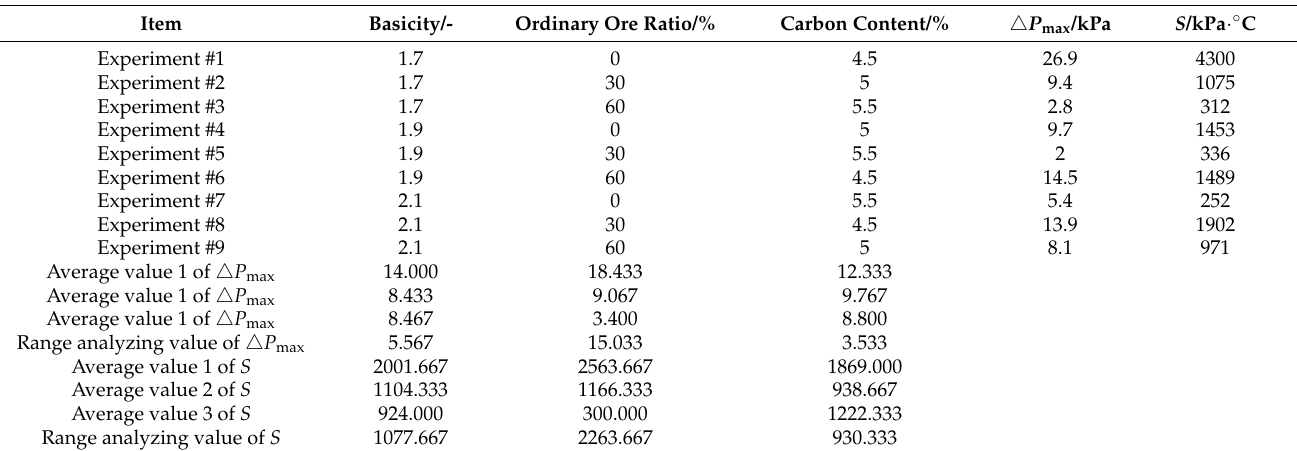
Table 14. Range analysis of gas permeability index.